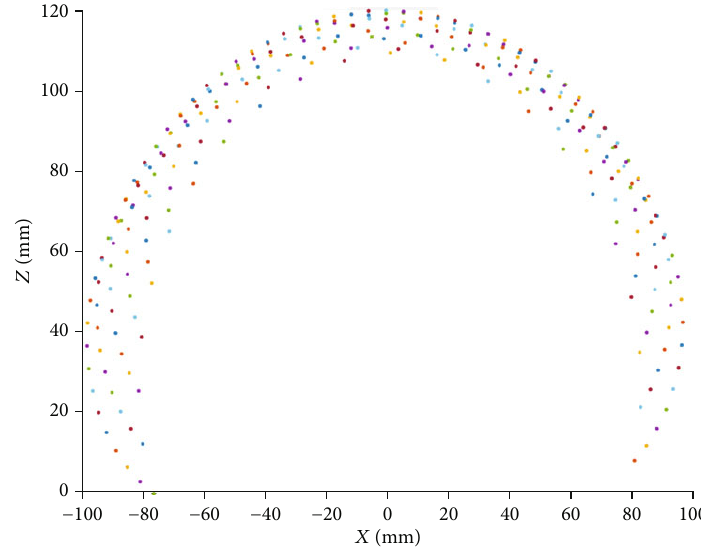
Figure 9: Two-segment catheter workspace in